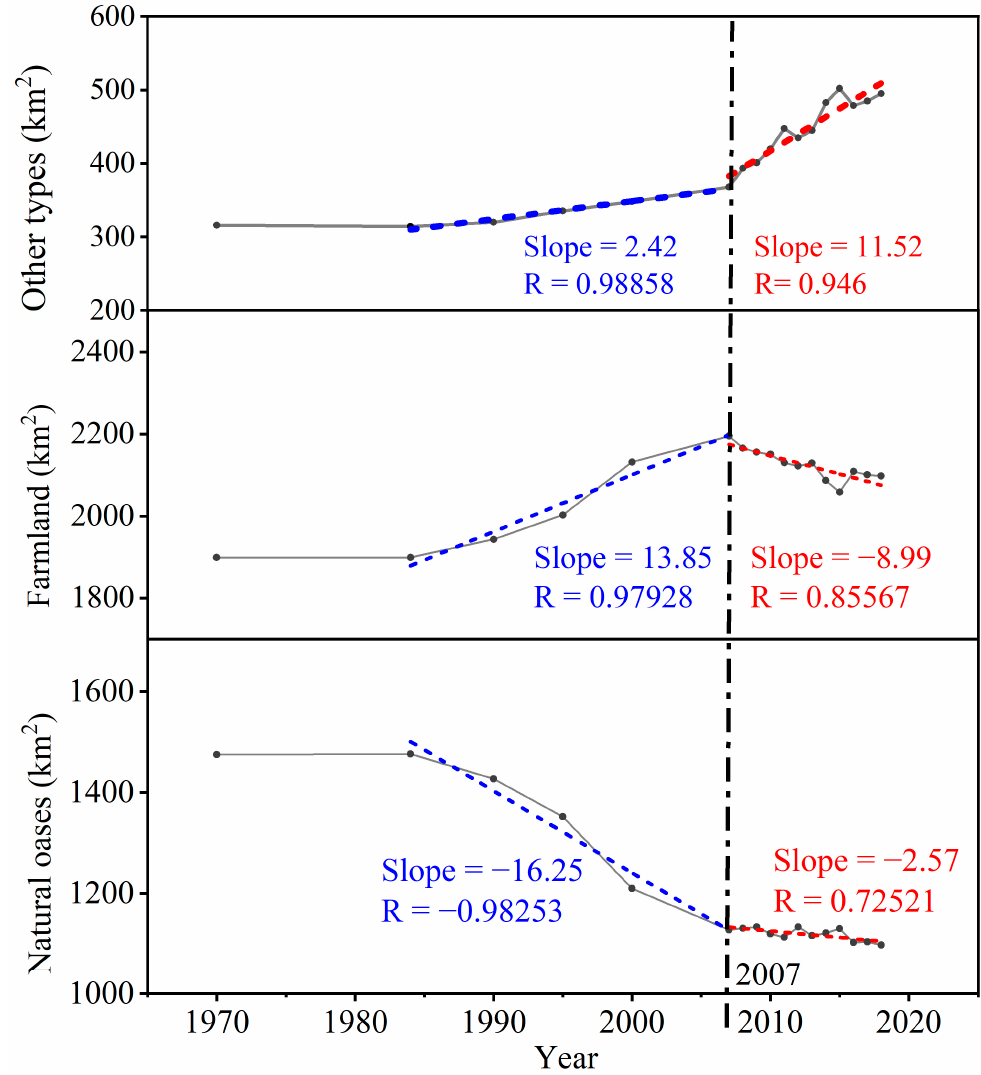
Figure 6. Changes in the areas taken up by the various land use/cover types. A correlation analysis between the farmland area and the natural oasis area (Figure 7) revealed that the natural oasis area decreased by 1.17 km 2 for every 1 km 2 of increase in farmland area before 2007. After 2007, the natural oases recovered by only 0.12 km 2 for every 1 km 2 of increase in farmland area. That is, only 0.12 km 2 of every 1.17 km 2 of